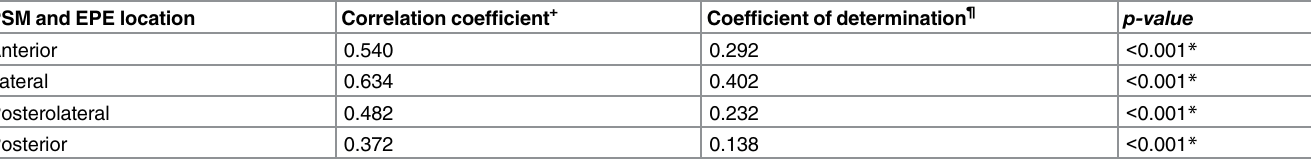
Table 3. Correlation between EPE location and PSM